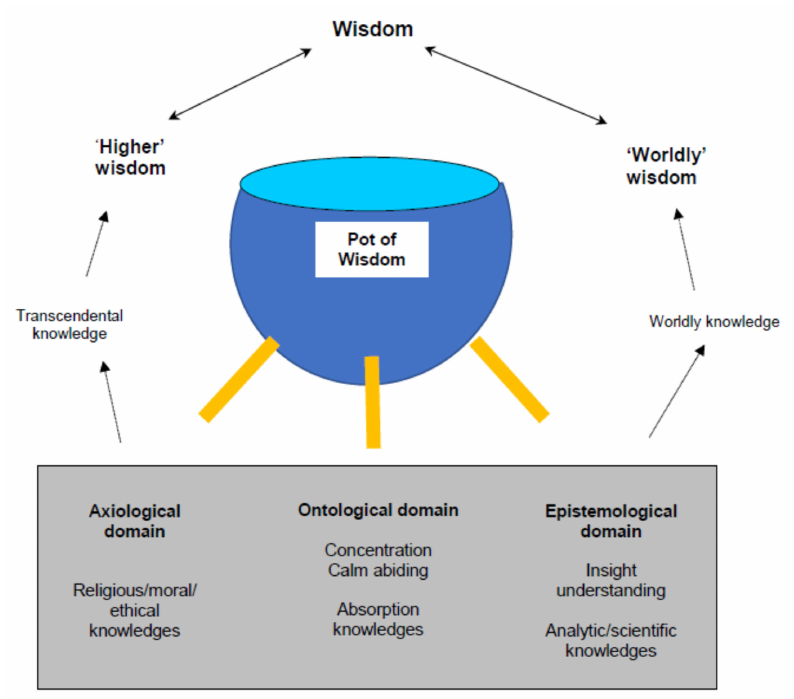
Figure 2. Balancing the domains of knowledge for the emergence of